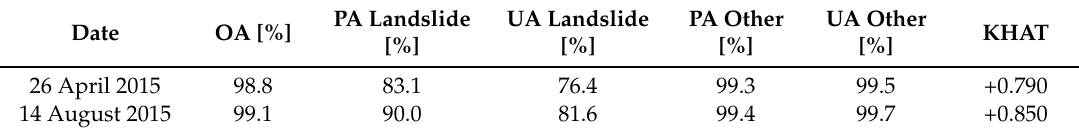
Table 4. Classification accuracies for the Russian mining waste landslide (1 April 2015). Only landslide material outside the original mining site is treated as a landslide. Overall accuracy (OA), user’s (UA), and producer’s accuracy